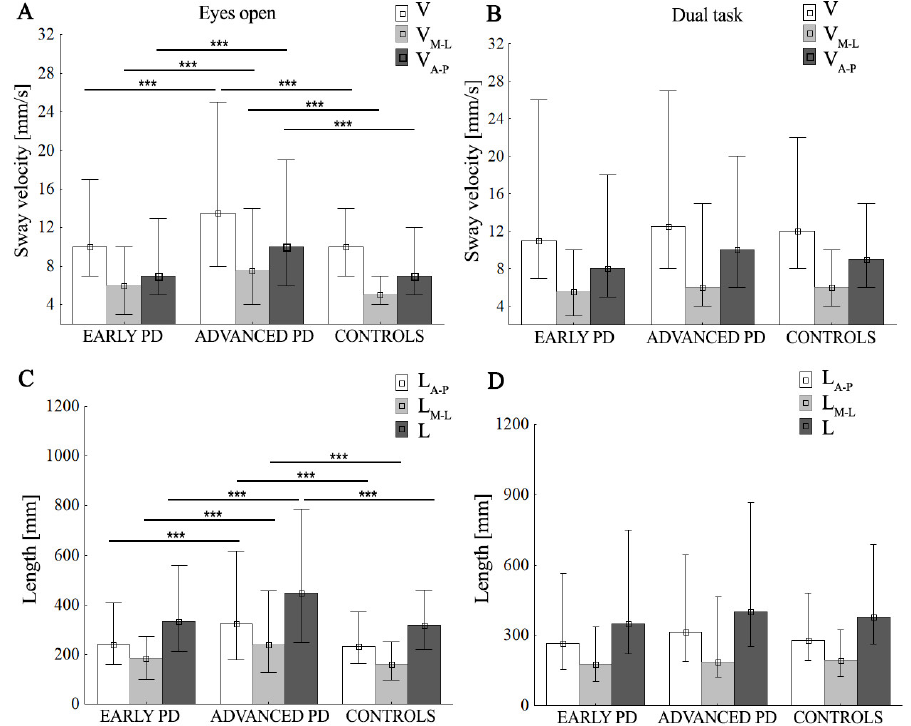
Figure 3. Group mean values (±SD) of sway velocity (V), mean sway velocity in medio-lateral (V M-L ) and anterior–posterior (V A-P ) ( A , B ), total length of stabilogram (L), medio-lateral length of stabilo- gram (L M-L ), and anterior–posterior (L A-P ) length of stabilogram ( C , D ), during eyes-open/dual task. Statistically significant differences are indicated with *** p <